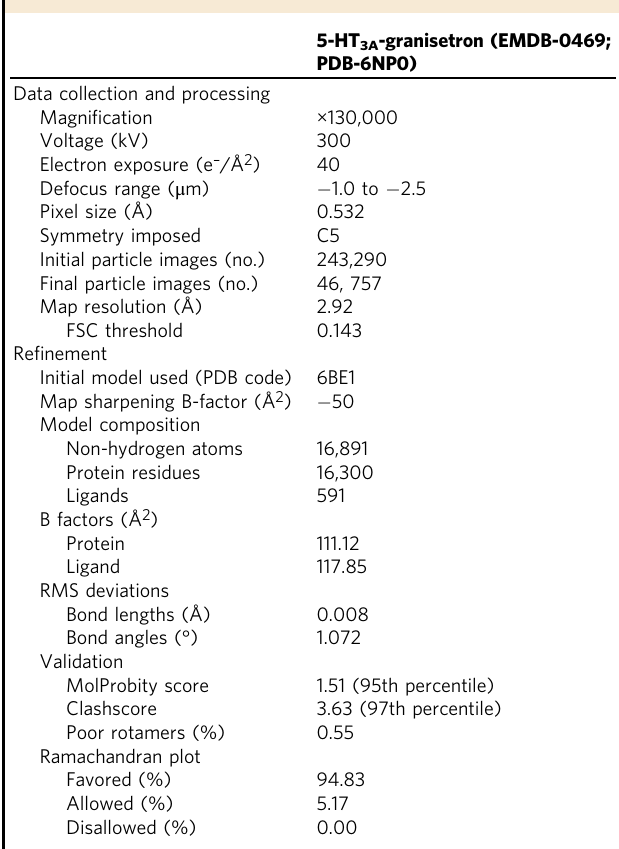
Table 1 Cryo-EM data